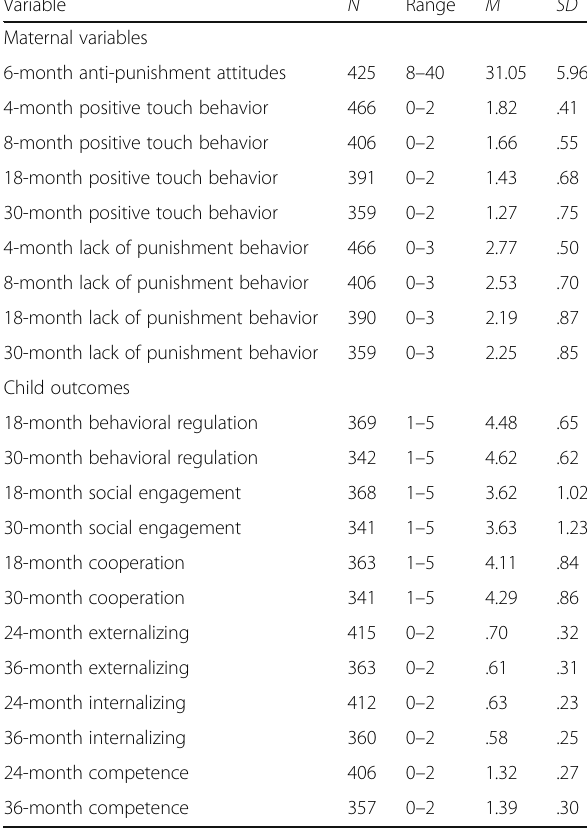
Table 2 Study 2 descriptive statistics for punishment attitudes, touch behaviors, and child